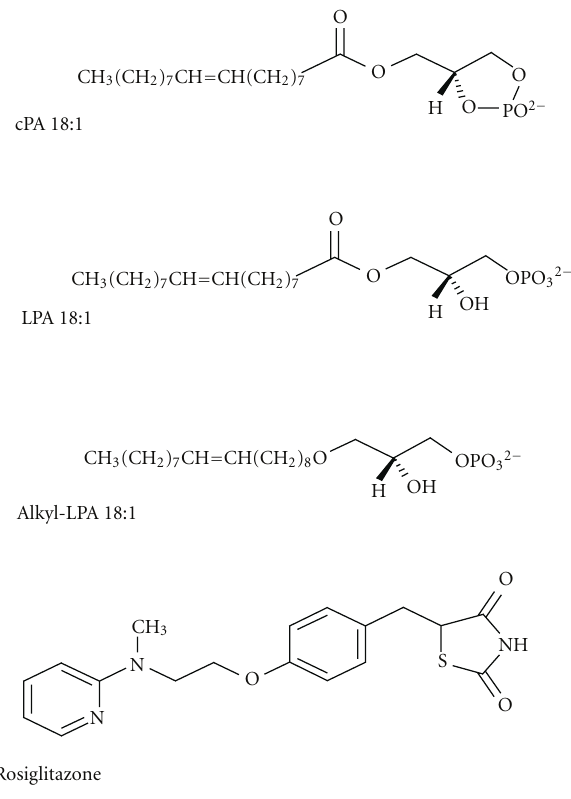
Figure 1: Structural formulas of LPA, alkyl-LPA, cPA,and rosiglita- zone. LPA is made up of a glycerol backbone with a hydroxyl group, a phosphate group, and a long-chain saturated or unsaturated fatty acid. Alkyl-LPA is an alkyl-ether analog of LPA. Alkyl-LPA shows a higher potency than LPA at the intracellular LPA receptor PPAR γ . cPA is a naturally occurring acyl analog of LPA. cPA is a weak agonist of plasma membrane LPA receptors, whereas cPA is an inhibitor of PPAR γ . Rosiglitazone is a thiazolidinedione (TZD) class of antidiabetics and is full agonist of PPAR γ